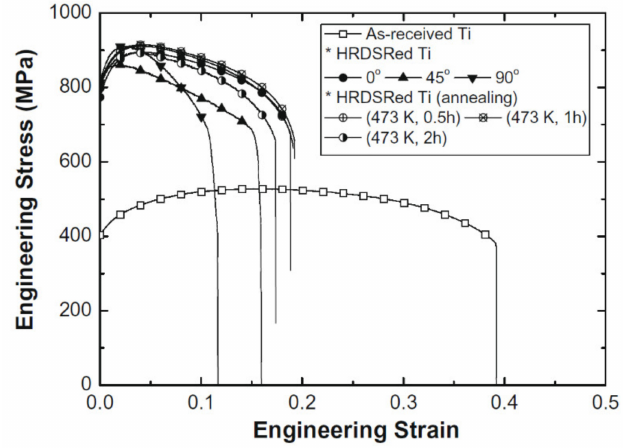
Figure 42. Stress–strain curves of the as-received and the HRDSR-processed Ti sheets, reproduced from [20], with permission from Elsevier,